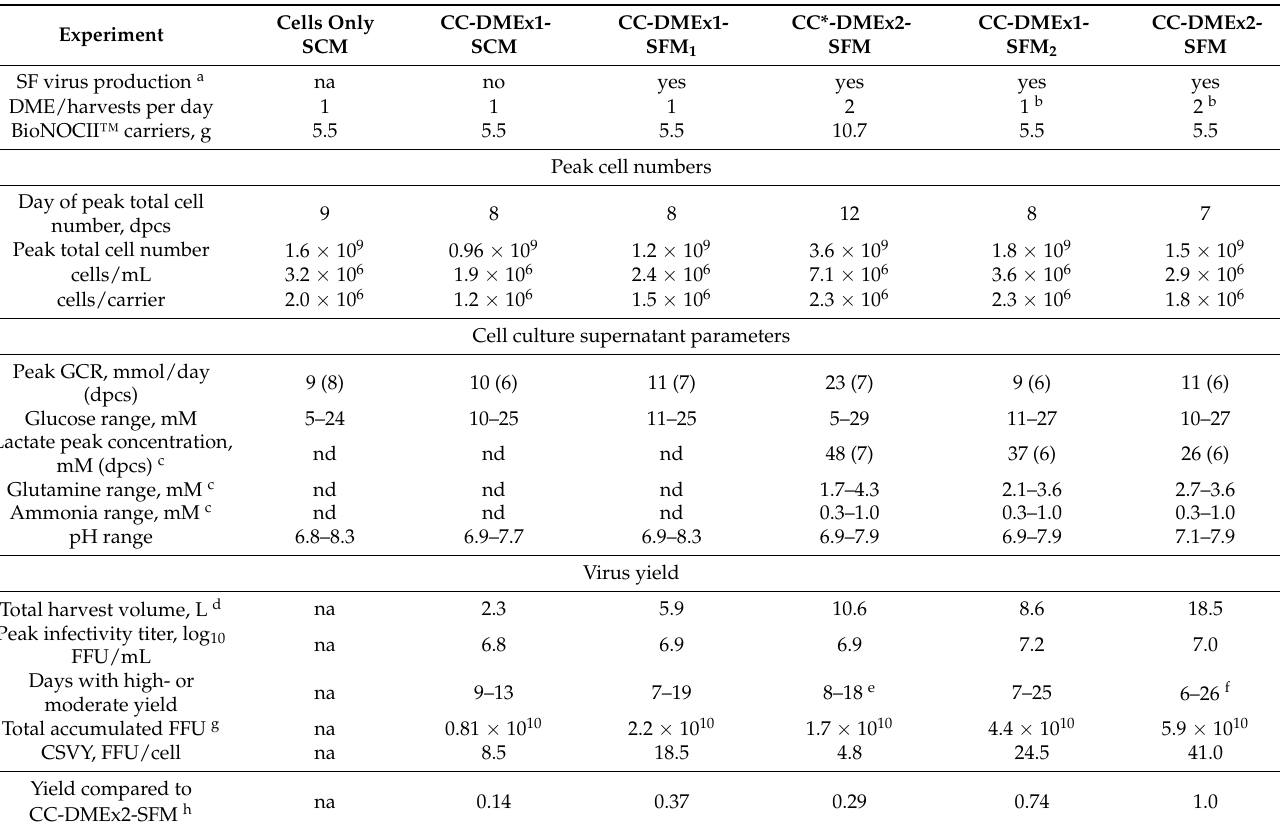
Table 1. Overview of cultivation parameters, rates, and yields of CelCradle™